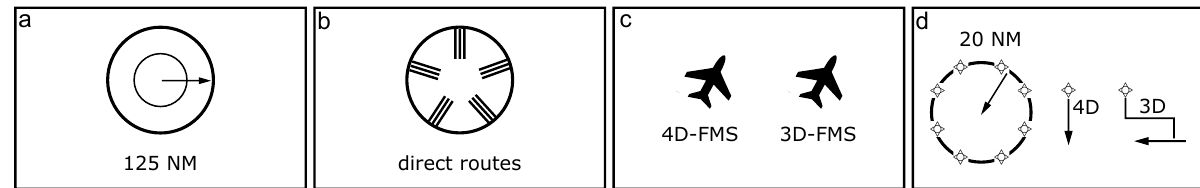
Figure 1. Four fundamental steps to enable green approaches: ( a ) extend the terminal manoeuvring area to 125NM, ( b ) enable direct routes towards the airport, ( c ) distinguish aircraft by flight man- agement system functionality and ( d ) introduce aircraft separation points and different routes to the end